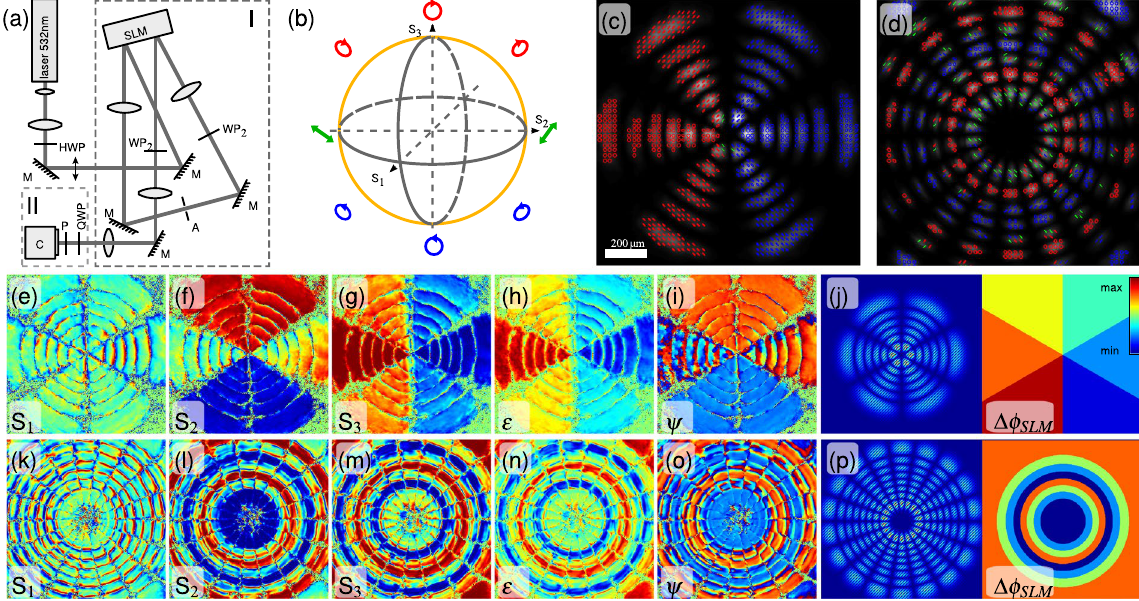
Figure 1. Polarization structured LG beams. ( a ) Experimental setup: polarization measurement system (II) and DPMS combined with phase and amplitude modulation (I). C: camera, (H/Q)WP: (half/quarter) wave plate, M: mirror, P: polarizer. ( b ) Schematic of the subspace ( θ 1 = − 45°, θ 2 = 90°). ( c ) LG e with radially modulated polarization structure. Polarization states are depicted by red or blue ellipses/circles indicating right and left elliptical/circular polarization, respectively. Linear polarization states are shown by green lines. Stokes parameters S 1,2,3 ∈ [ − 1, 1] ( e – g , k – m ) as well as the ellipticity ε ∈ [ − 1, 1] ( h , n ) and the orientation ψ ∈ [ − π /2, π /2] ( i , o ) of polarization ellipses are given. Corresponding side-by-side holograms are shown in ( j , p